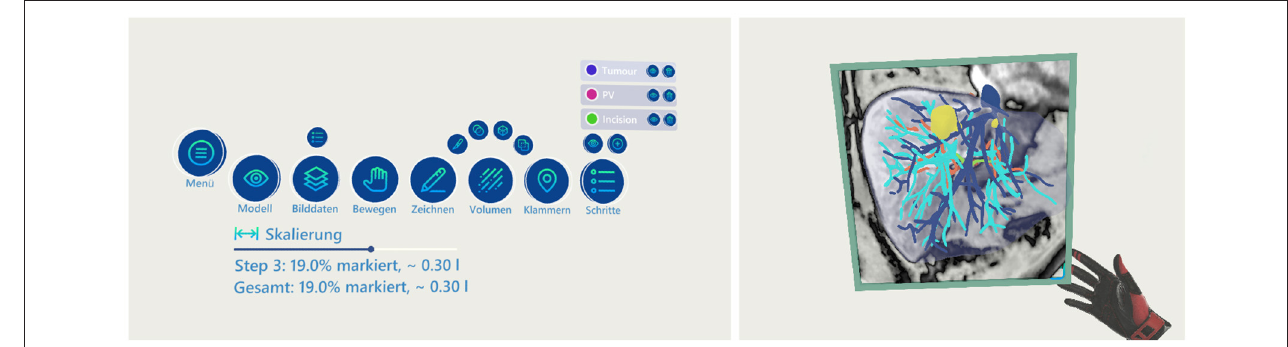
FIGURE 2 | The menu and the frame functionality—left: the menu showing all available functions; right: the frame showing an overlay of the MRI images at the given intersection of the model.